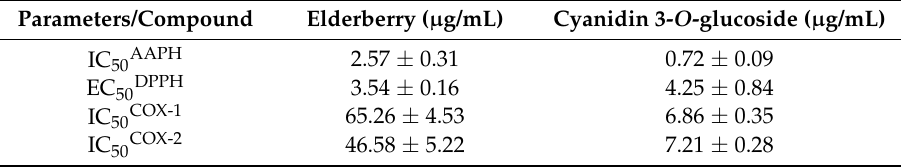
Table 4. Antioxidant (IC 50 ), antiradical (EC 50DPPH ) and anti-inflammatory (IC 50COX-1 , IC 50COX-2 ) parameters for elderberry extract and cyanidin 3- O -glucoside and values of IC 50COX-1 and IC 50COX-2